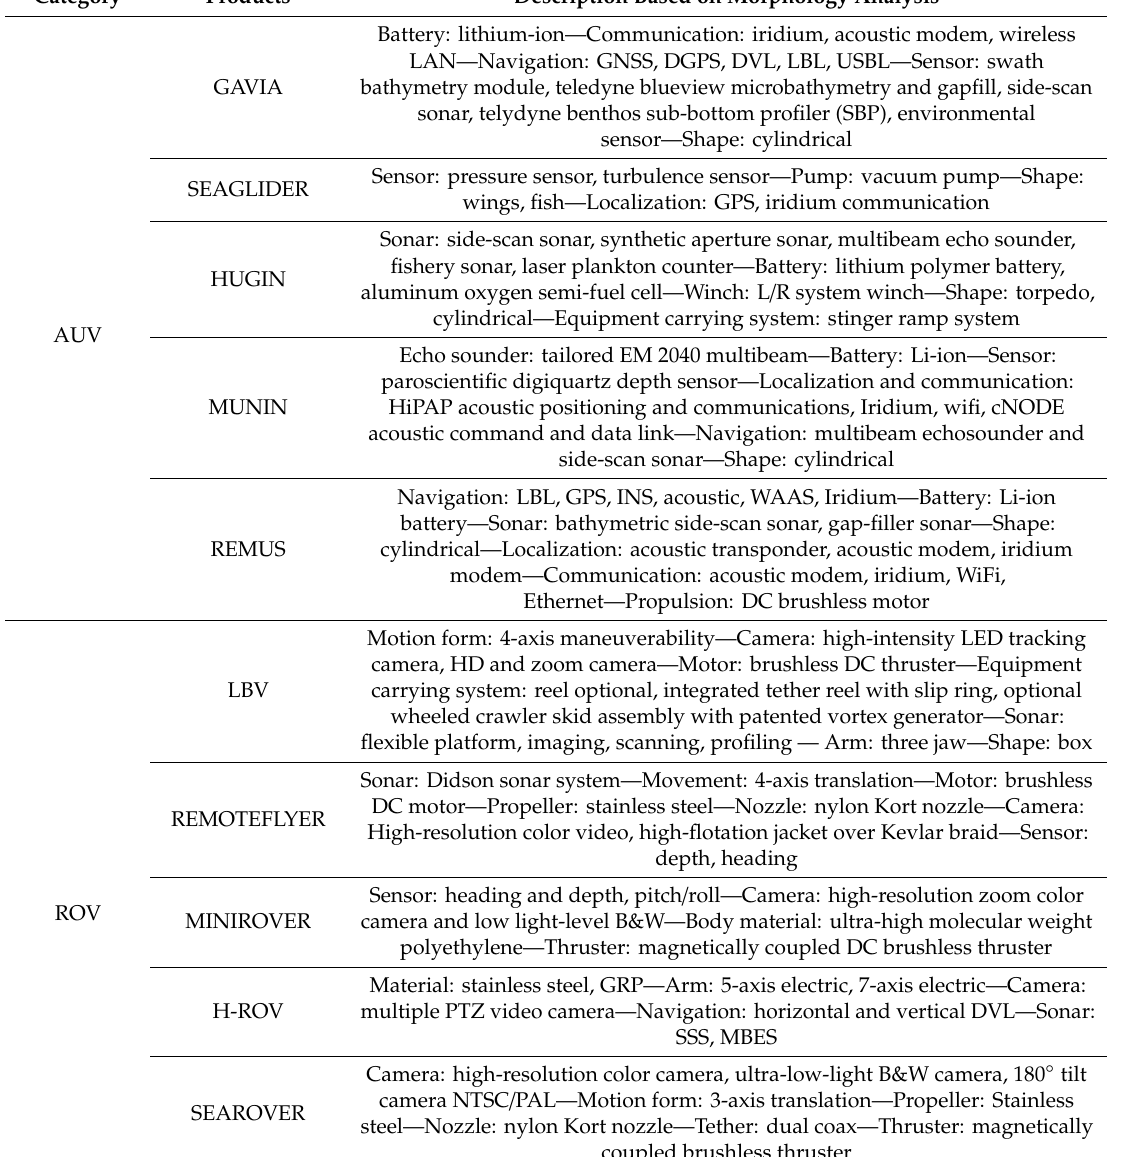
Table 7. Product description based on